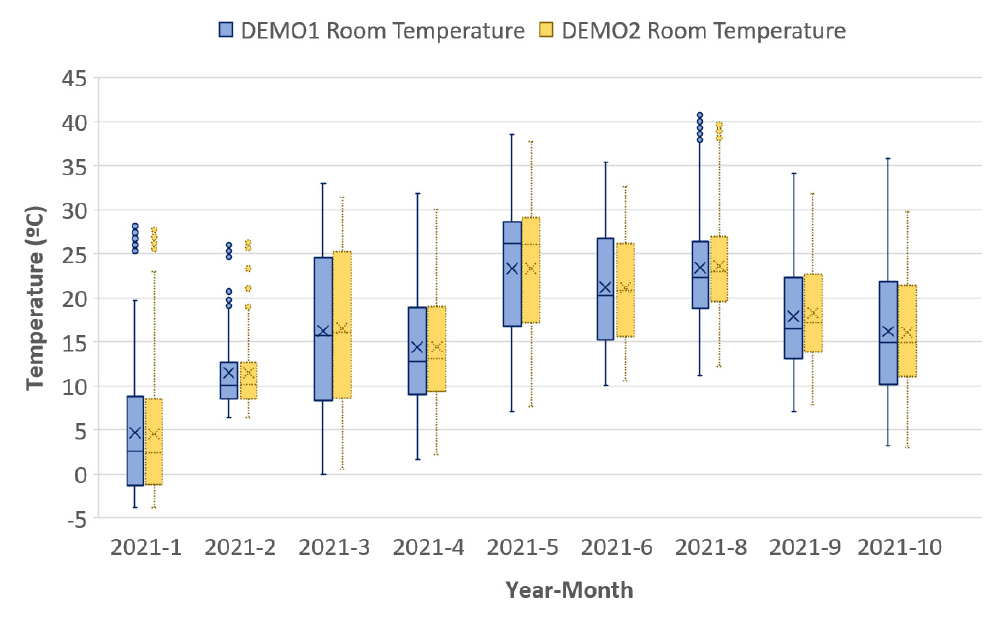
Figure 9. Statistical analysis per month for the comparison of indoor room temperature values monitored at DEMO1 (reference) and DEMO2 (test cell) during free-floating temperature mode periods with indoor coating elements based on CrodaTherm TM ME29P.